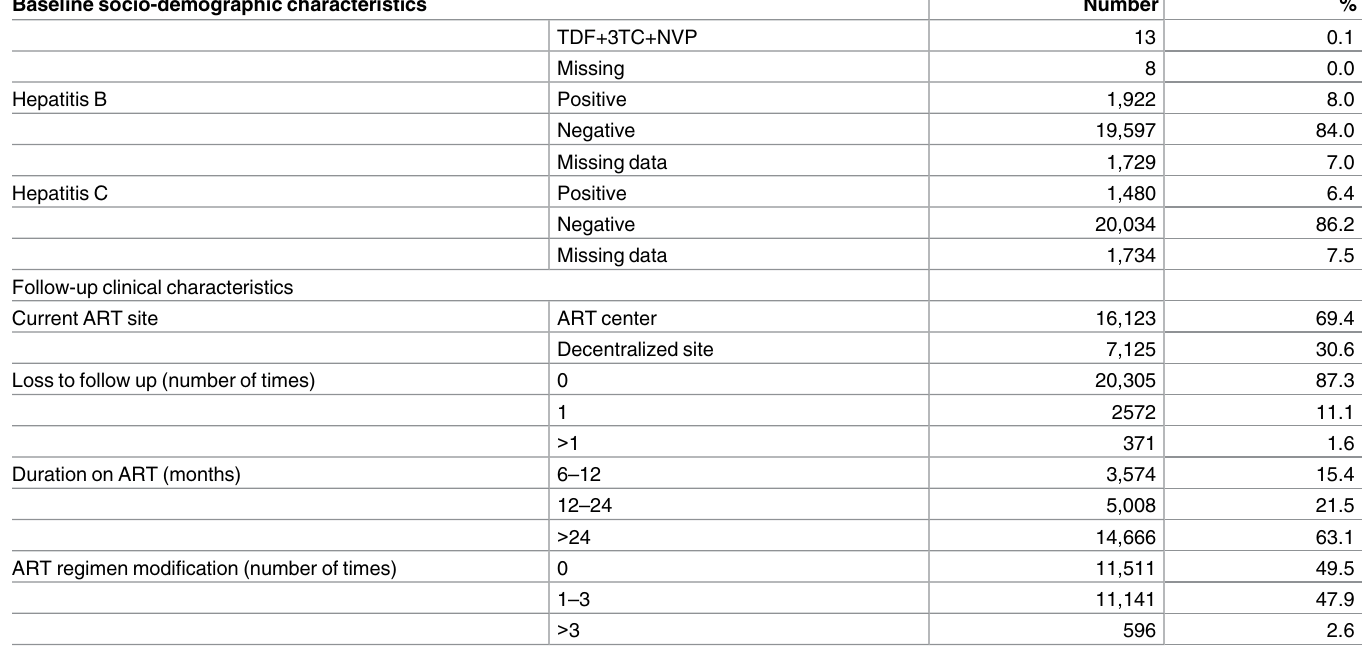
12% (Fig 2). Of 931 patients who switched to second-line ART, 88% were switched due to treatment failure, 1.3% due to toxicity and 10% had no recorded information. Stratified by duration on first-line ART, the incidence of switching to second-line ART in patients who were on ART for less than one year, between one and two years and more than two years was 4.49, 3.91 and 0.89 per 100 PYFU